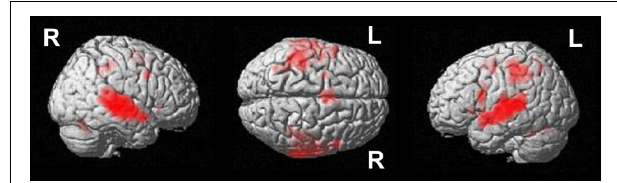
FIGURE 4 | Conjunction analysis over all groups and conditions at an uncorrected voxelwise p < 0 . 0001 (cluster-corrected FWE of p < 0 .